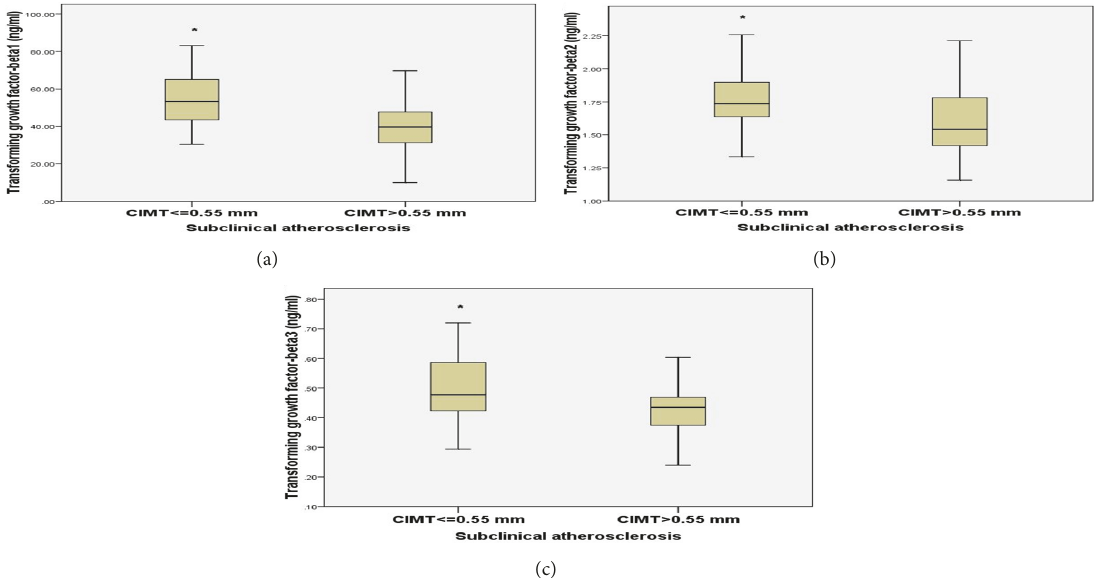
Figure 1: Comparison of serum transforming growth factor- 𝛽 1 (a), 𝛽 2 (b), and 𝛽 3 (c) between patients with subclinical atherosclerosis andthosewithoutatherosclerosis. Theboxesindicatemedian,25th,and75thpercentile;whiskersrepresentdatarange;whiskercapsindicate 5th and 95th percentile. Transforming growth factor- 𝛽 1, 𝛽 2, and 𝛽 3 levels were analyzed with Bio-Plex Pro (cid:3) TGF- 𝛽 Assays kit. Carotid intima media thickness was measured using B-mode ultrasound. Serum transforming growth factor- 𝛽 1, 𝛽 2, and 𝛽 3 levels were compared between CKD patients and controls, ∗ P < 0.001 compared to